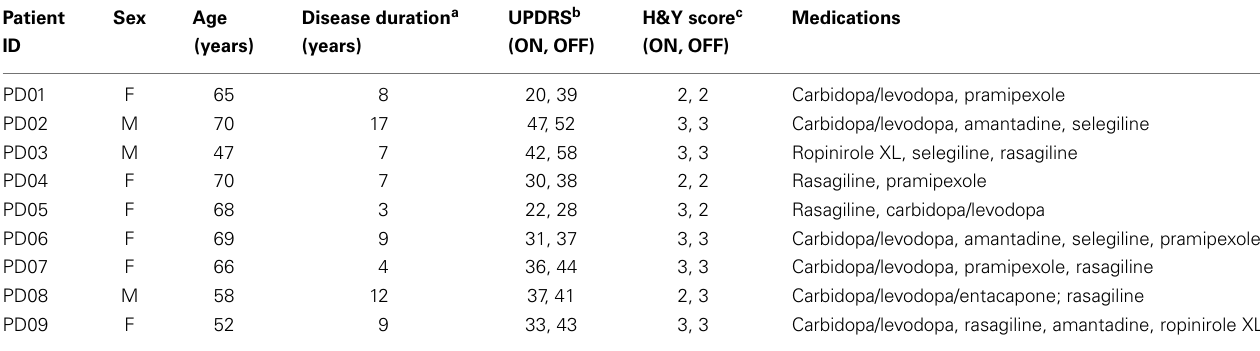
Table 1 | Clinical characteristics of Parkinson’s disease